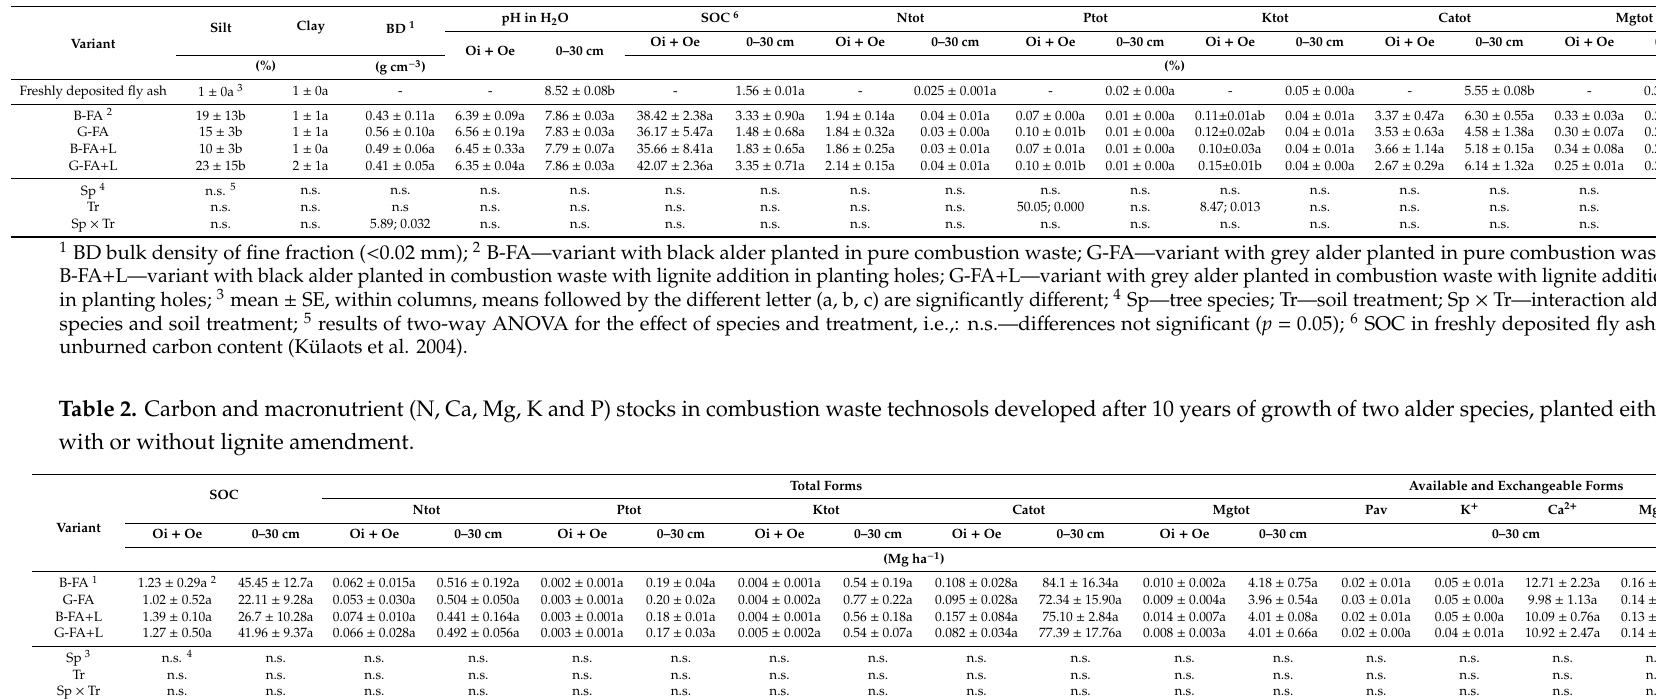
Table 1. Technosol parameters in freshly deposited fly ash and after 10 years of growth of two alder species, planted with and without lignite amendment. Variant Freshlydepositedflyash